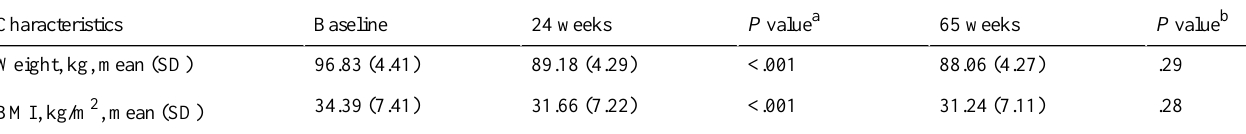
Table 3. Weight change from baseline to 24 weeks and 65 weeks in maintenance completers (n=32). BMI: body mass index.